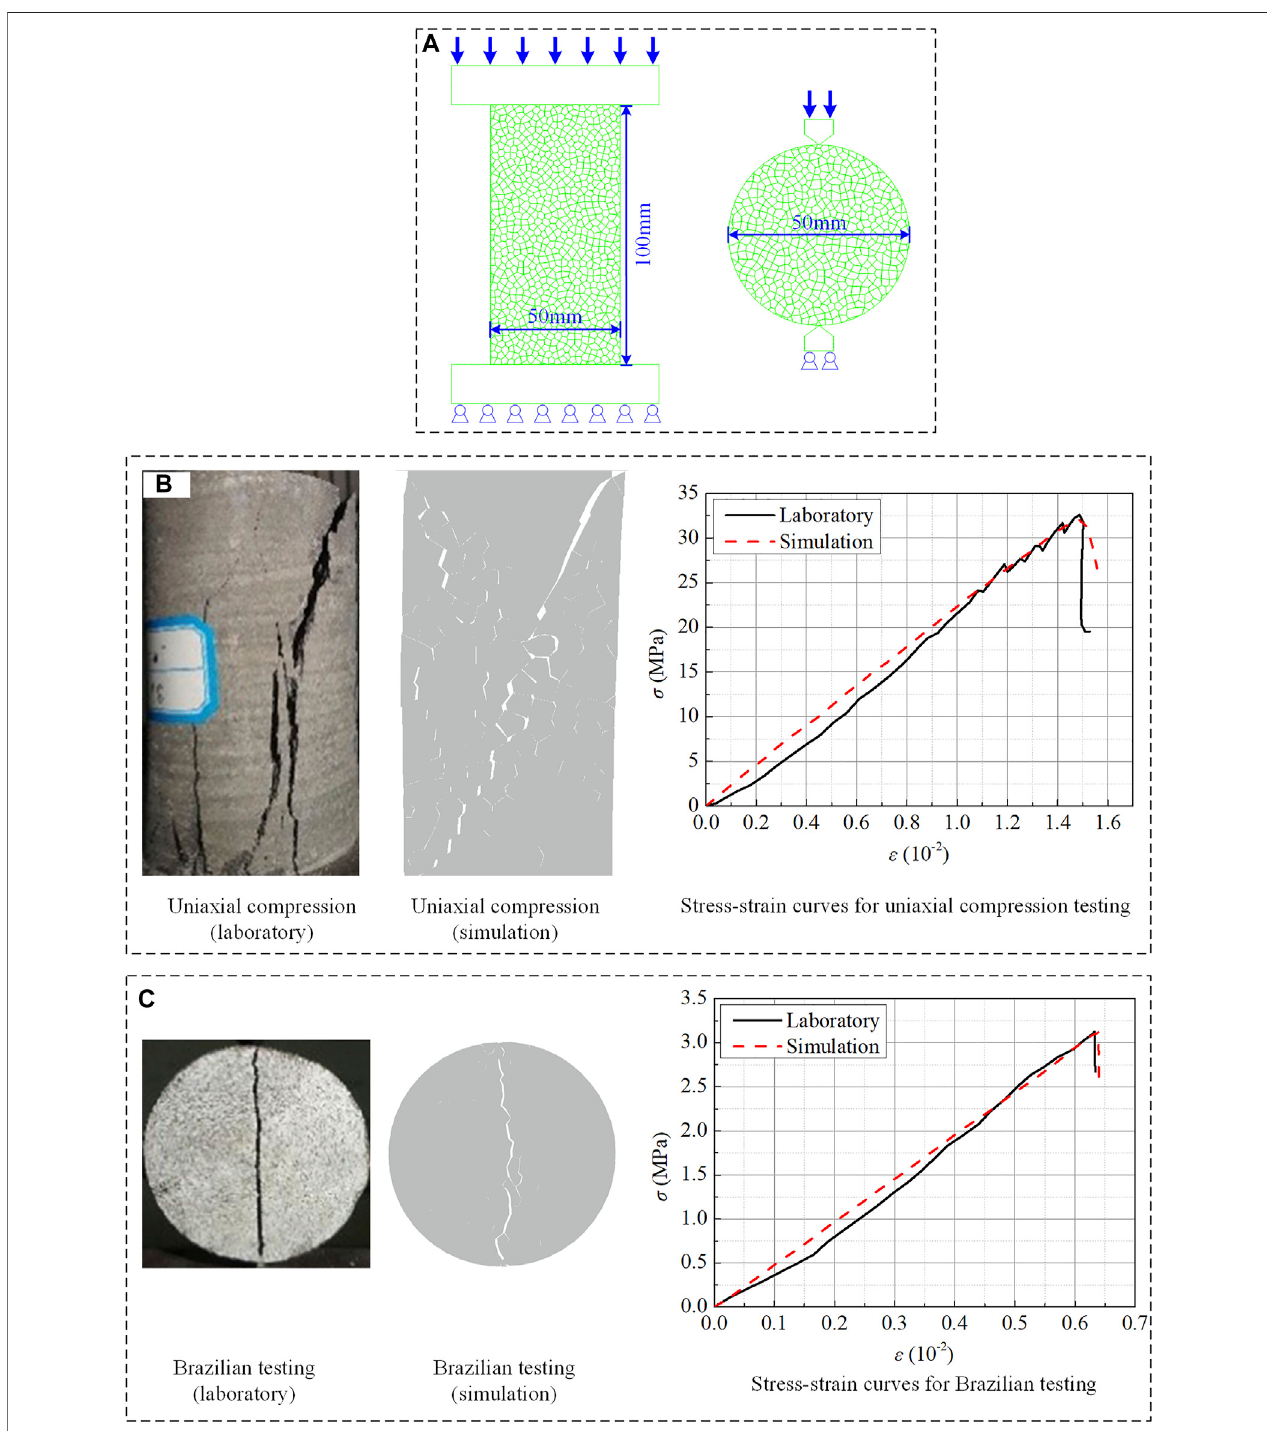
FIGURE 7 | Construction and calibration of numerical modeling: (A) model construction; (B) comparison of uniaxial compression; (C) comparison of Brazilian splitting.